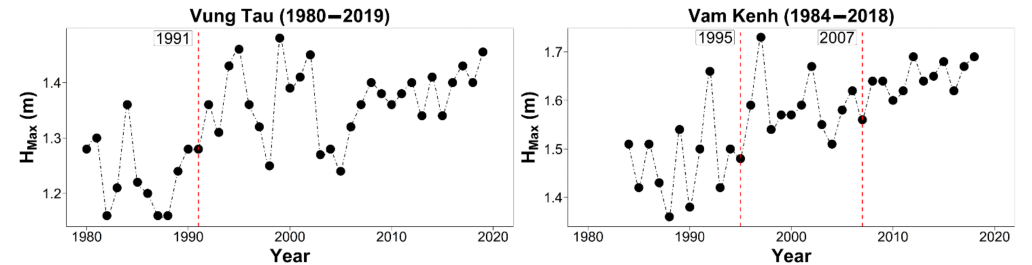
Figure 6. Changepoint years showing possible shifts in H max